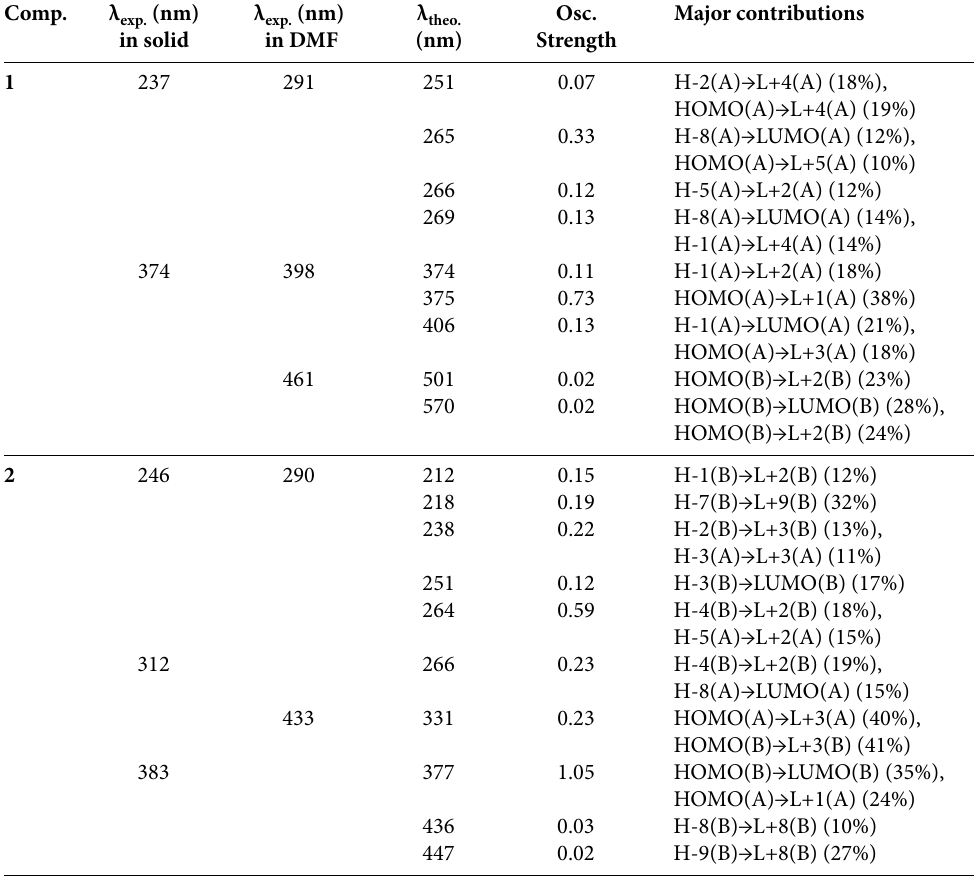
Table 5. The electronic spectral data and calculated electronic transitions of complex 1-5 and their contributions.